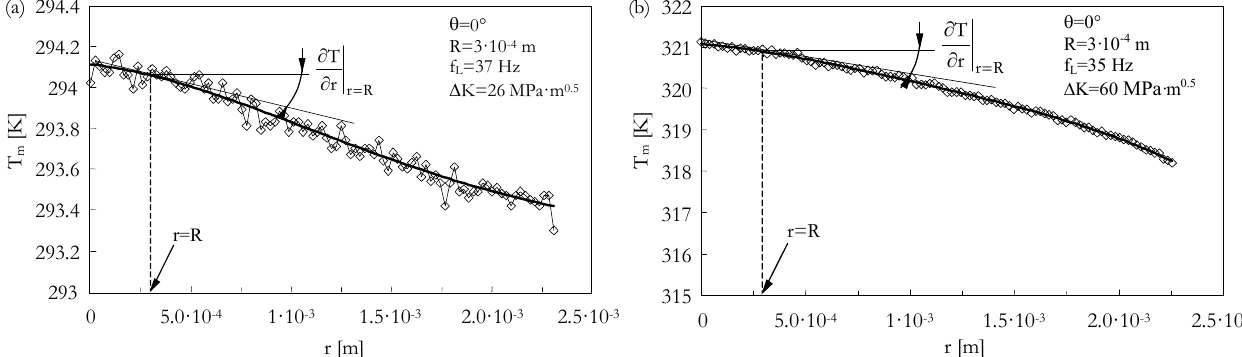
Figure 4: Typical radial temperature profiles measured during the tension-compression fatigue tests in the case of (a)  K=26 MPa·m 0.5 and (b)  K =60 MPa·m 0.5 .